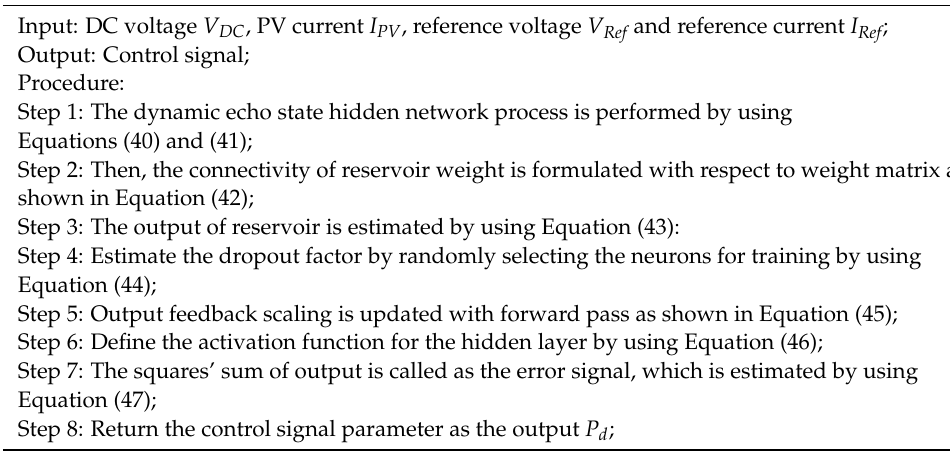
Figure 9. Flow of RaERC. Algorithm 3 Residual Attention Echo State Reactive Controller (RaERC)